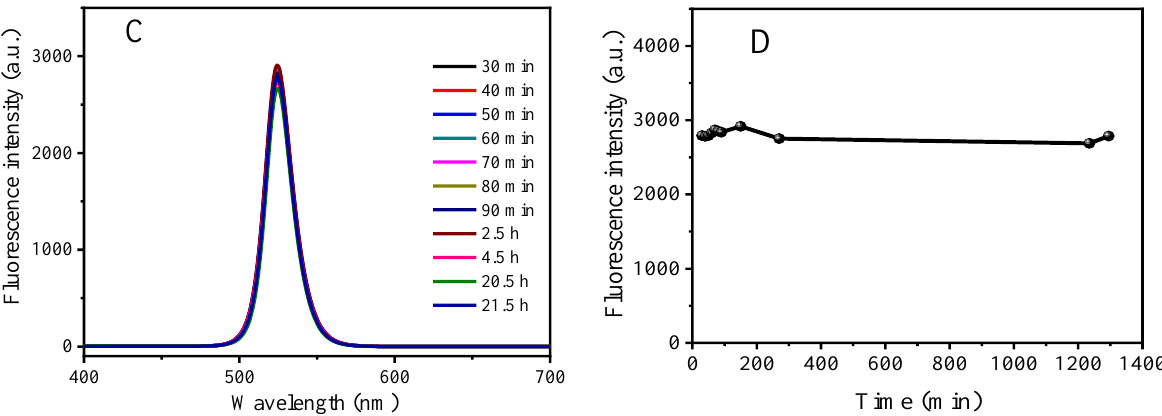
Figure 4. Variation of fluorescence intensity of CsPbBr 3 /Cs 4 PbBr 6 PNCs, with temperature ( A , B ) and time ( C , D ). Experimental conditions: synthetic precursors: CsBr (45.4 mM), PbBr 2 (45.4 mM), N-6- trifluoroacetyl-L-lysine (4.54 mM), reaction time: 2.5 h, reaction temperature: − 18 °C. Synthesis of CsPbBr 3 /Cs 4 PbBr 6 PNCs: OLA (250 μL), precursor (1.375 mL). Reaction time: 20 min, reaction temperature: 25 °C.